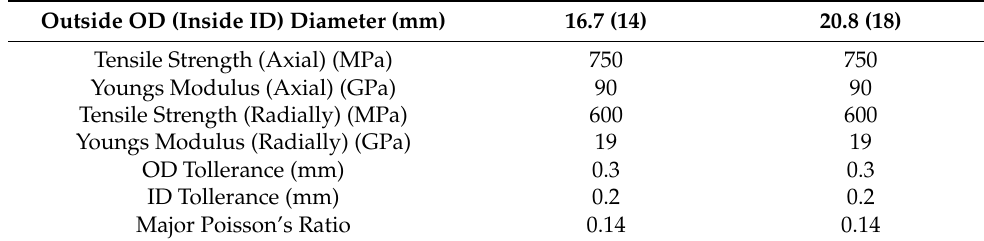
Table 1. Parameters of carbon fiber-wrapped tubes [19].